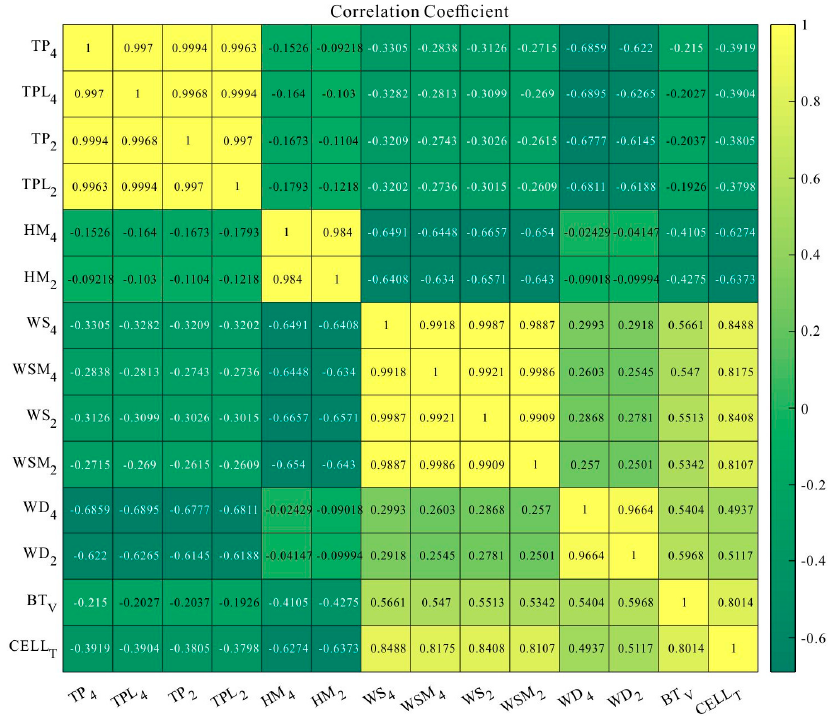
Figure 3. Correlation diagram of the nine input parameters of the deployed weather station (weather station panda 300 for example).